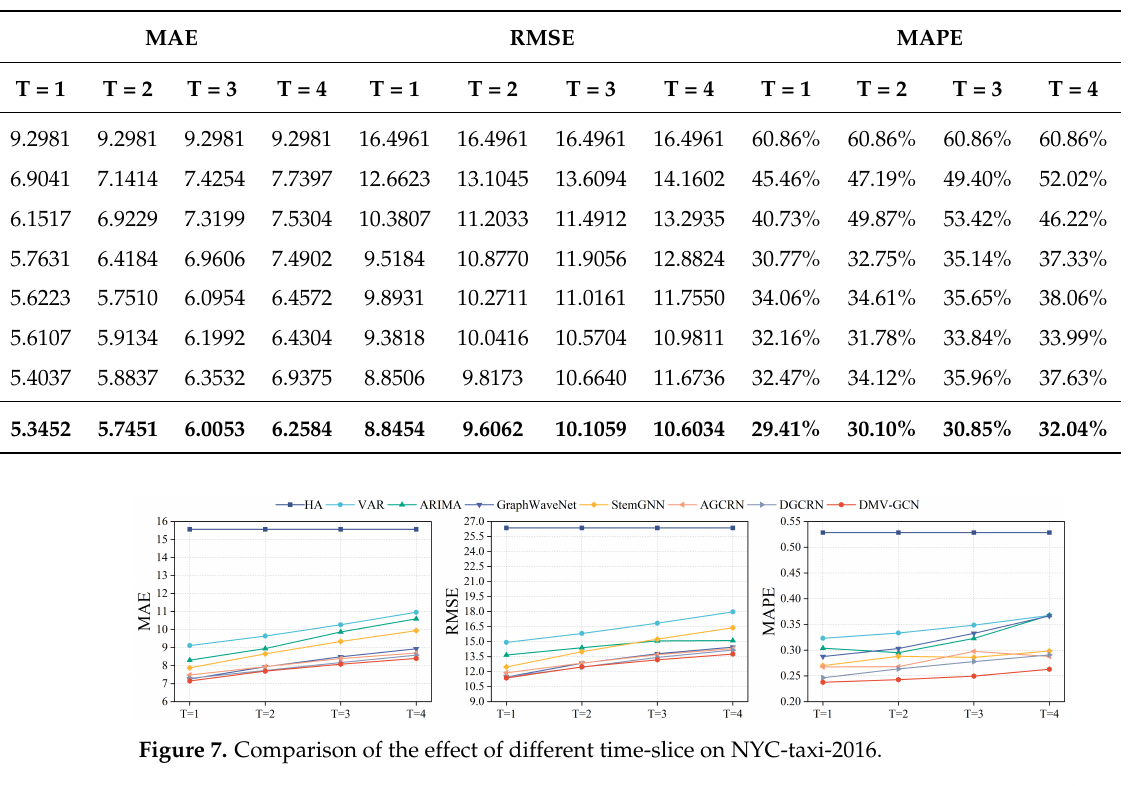
Table 2. Comparison of experimental results on the NYC-taxi-2019 datasets.